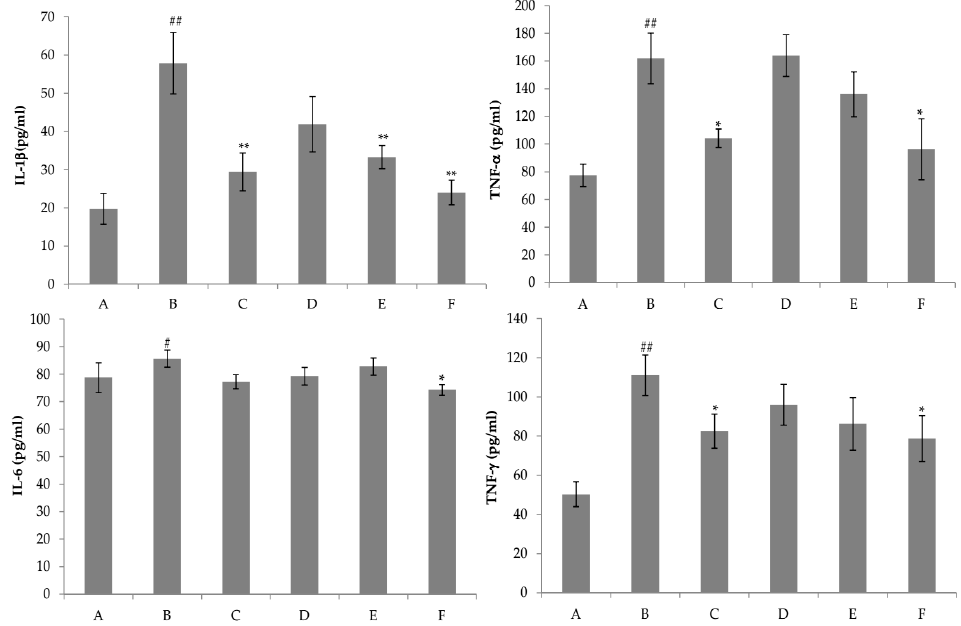
compared with the D -GalN